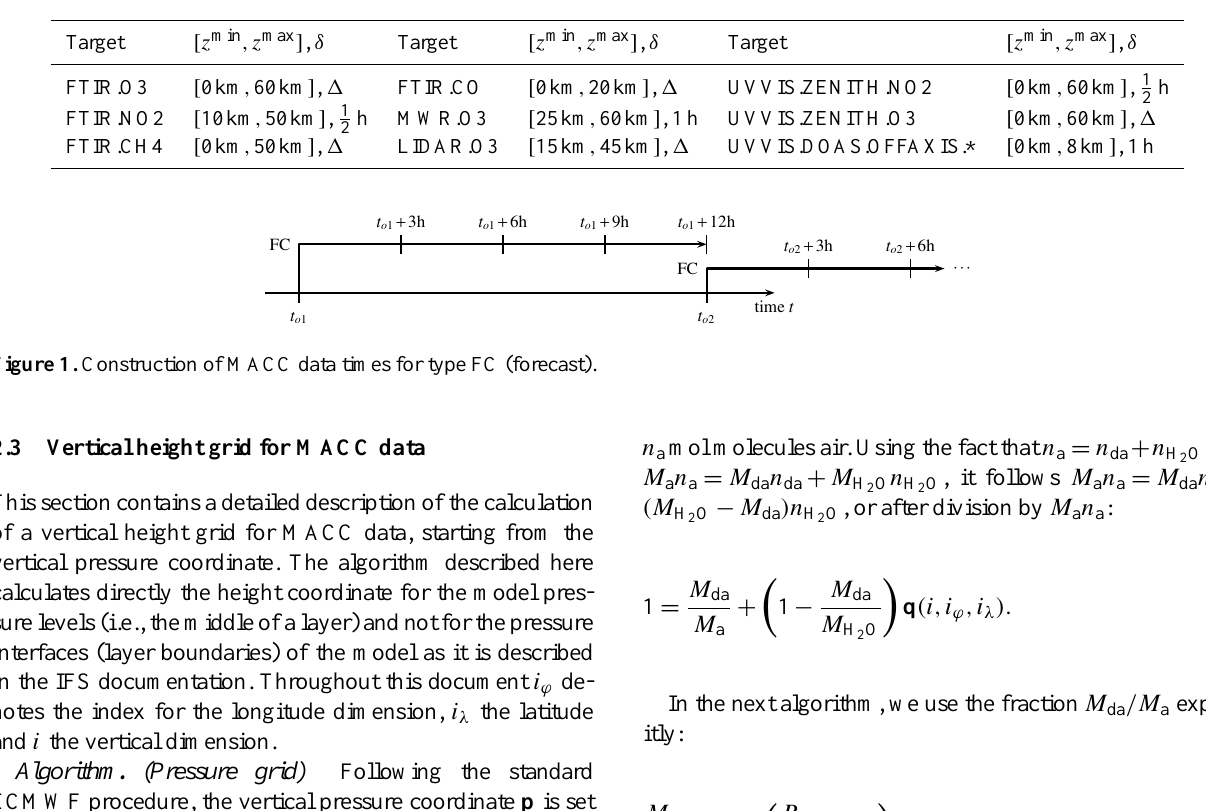
Table 4. List of default z min ,z max values for NORS target species, based upon the measurement’s sensitivity range and upper boundaries of MACC models, and of time windows for temporal co-location, based on species temporal variability. (cid:49) is the time between two subsequent MACC data validity times – see text (target values may contain wildcards if applicable to multiple targets).